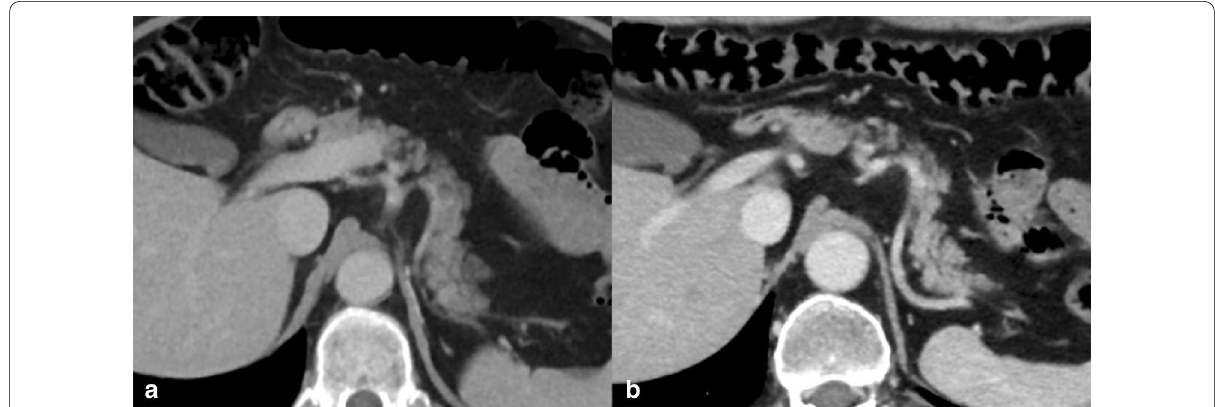
Fig. 18 Pancreatic atrophy in a 50-year-old man with metastatic clear cell renal cell carcinoma. Baseline axial CT scan show mild fatty infiltration of the pancreatic parenchyma ( a ). Axial CT scan performed after 2 years of sunitinib treatment ( b ) shows advanced pancreatic atrophy with the decrease in size of the pancreatic body/tail, fatty-fibrous replacement, increased lobular appearance of the gland and decreased attenuation